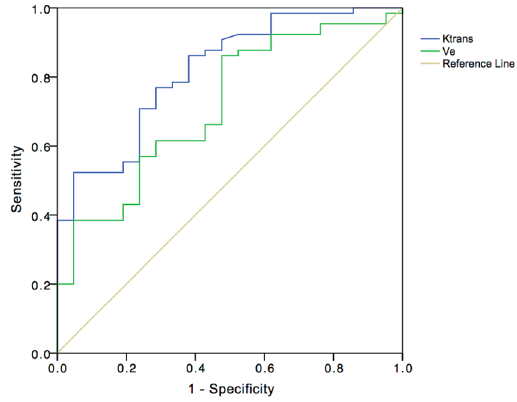
Figure 5. ROC curve of K trans (blue line) and V e (green line) shows comparisons of K trans and V e in ccRCC and non–ccRCCs. With a K trans value of 0.330 min − 1 , sensitivity and specificity were 76.9% and 71.4%, respectively, and the AUC was 0.819. With a V e of 0.327, sensitivity and specificity were 86.2% and 52.4%, respectively, and the AUC was 0.716.